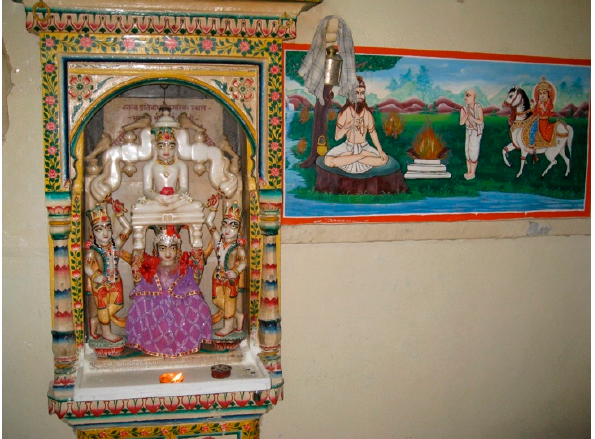
Figure 1. Padm ā vat ī shrine in the Cint ā ma ṇ i P ā r ś van ā th temple near R ā m Gh ā ṭ , Varanasi. Nineteenth Century.